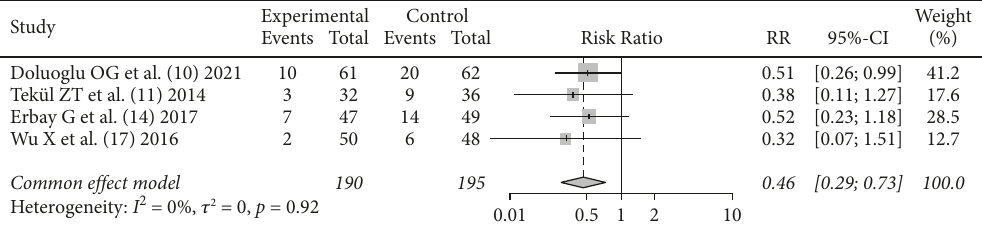
Figure 5: Comparison of tumor recurrence rate after TURBT between SA+ ONB and SA